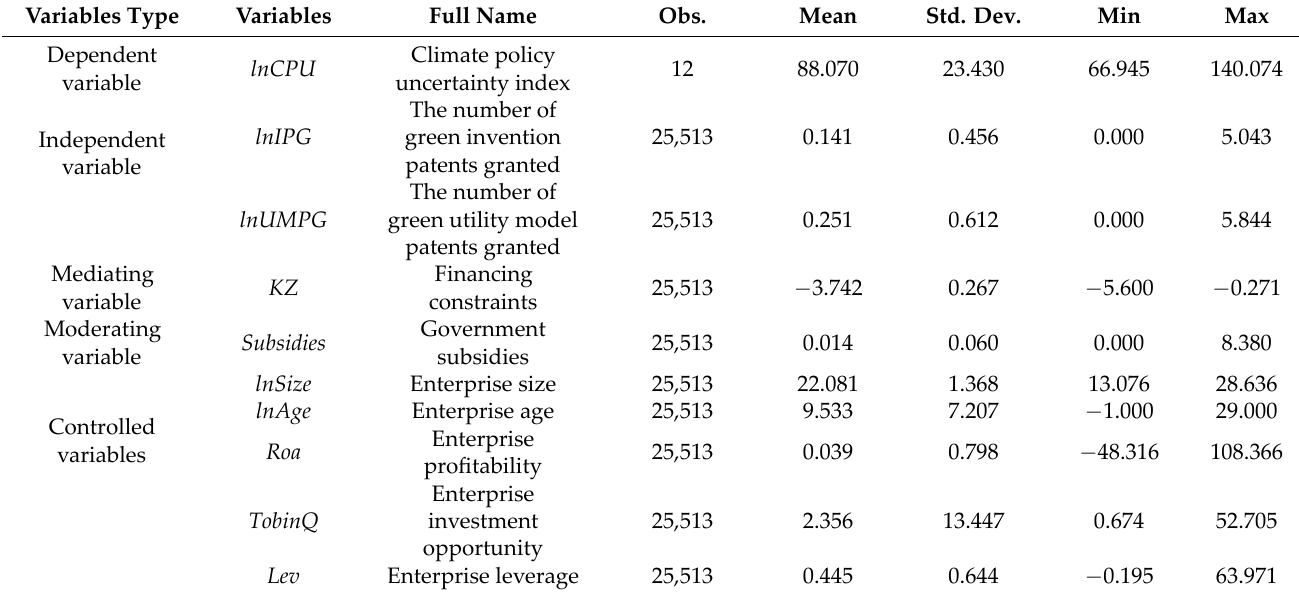
Table 2. Descriptive